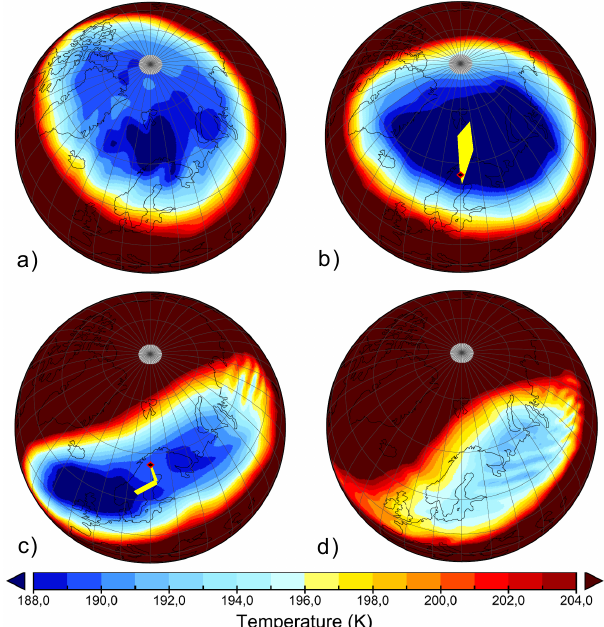
Figure 1. ERA-Interim data of temperature at the 30hPa level dur- ing RECONCILE in January 2010. (a) 10 January 00:00UTC. (b) 17 January 12:00UTC, corresponding to the first PSC flight. Here the measurement region of the first four flights (17–24 January) is indicated by the yellow area. (c) 25 January 12:00UTC, the last flight with PSC occurrence as indicated by the flight track. (d) 28 January 18:00UTC. The darkest blue color in the plot is scaled for temperatures below 188K to illustrate regions with temperatures close to or below T ICE